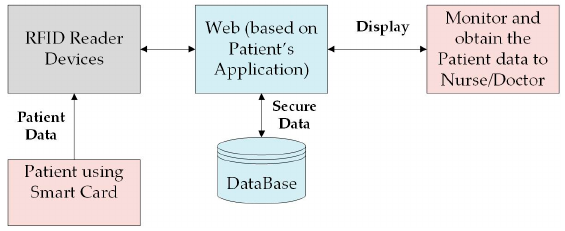
Figure 10. SOA-based Patient Monitoring System [41].